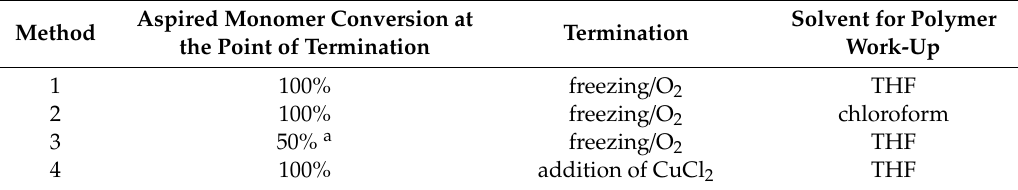
Table 2. Strategies of terminating the polymerization and working up the polymer. Method